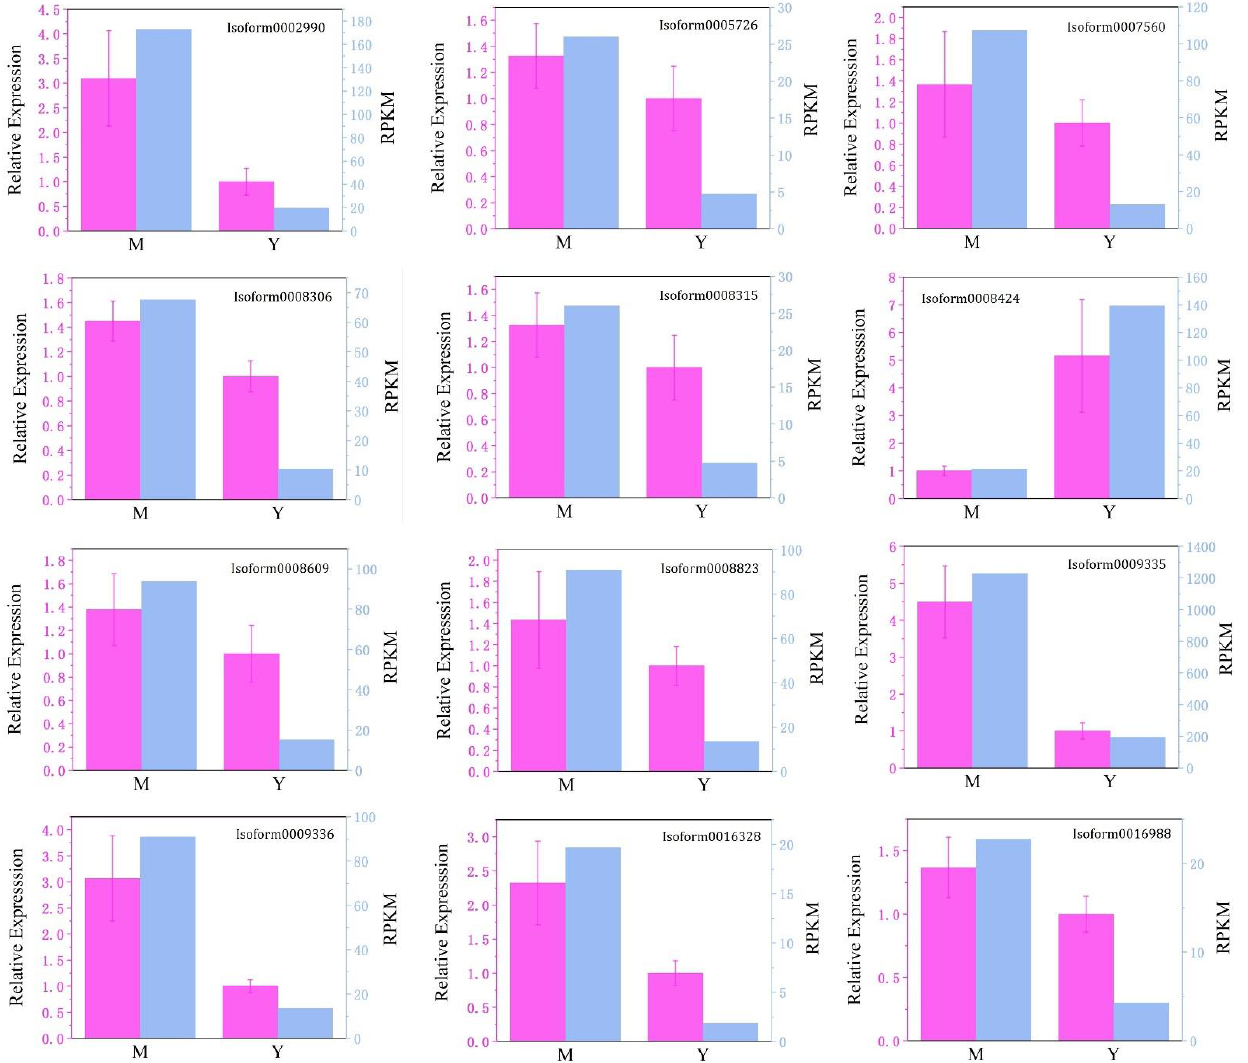
Figure 8. qRT-PCR validation of selected DEGs from the RNA-seq data. The relative expression levels shown in purple were estimated from the threshold of the PCR cycle with the delta delta CT method. The error bars indicate the standard error between 3 biological replicates. The FPKM data of the genes shown in blue bars were obtained by RNA-seq.